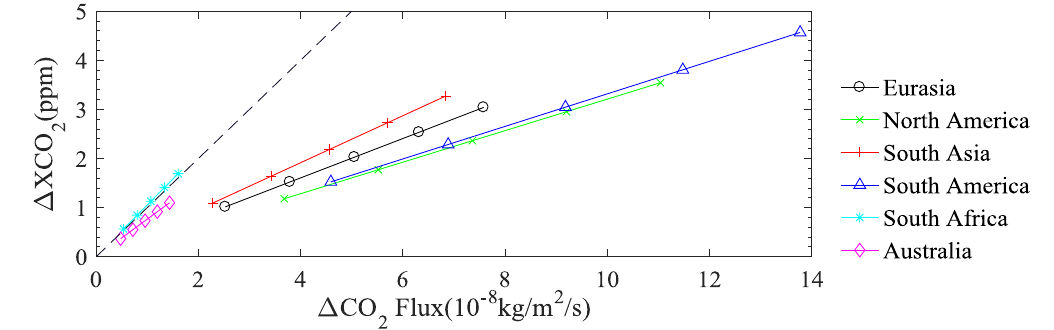
Figure 7. Increased XCO 2 (ΔXCO 2 ) corresponding to enhancements of local CO 2 fluxes (ΔCO 2 Flux) in regions of interest. Different color lines indicate different regions (black: Eurasia; green: North America; red: South Asia; blue: South America; cyan: South Africa and magenta: Australia). The black dashed line shows the one-to-one relationship.